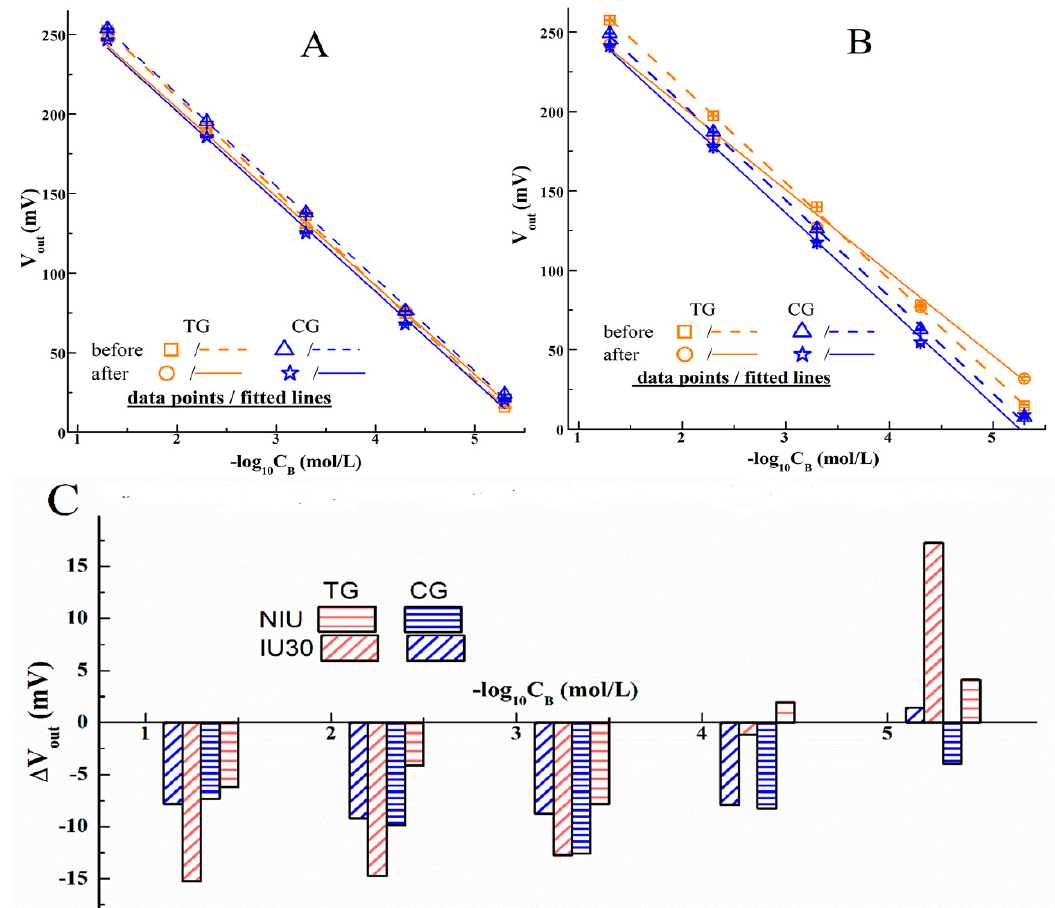
Figure 4. The responding data and the fitted lines of AS1411 functionalized I − -ISEs (without PGO) for the KI / KNO 3 solution for the varied concentrations (C B ), before and after they are immobilized by cells (MDAMB231) in the test group (TG, the orange symbols and lines) and the control group (CG, the blue ones). ( A ) is the result of ISEs before and after being fixed by the cells without the treatment of IU; ( B ) is the result of ISEs before and after being fixed by the cells with IU operation for 30 min, abbreviated as IU30; ( C ) is the data of the varied V out ( ∆ V out ) due to the immobilized cells.